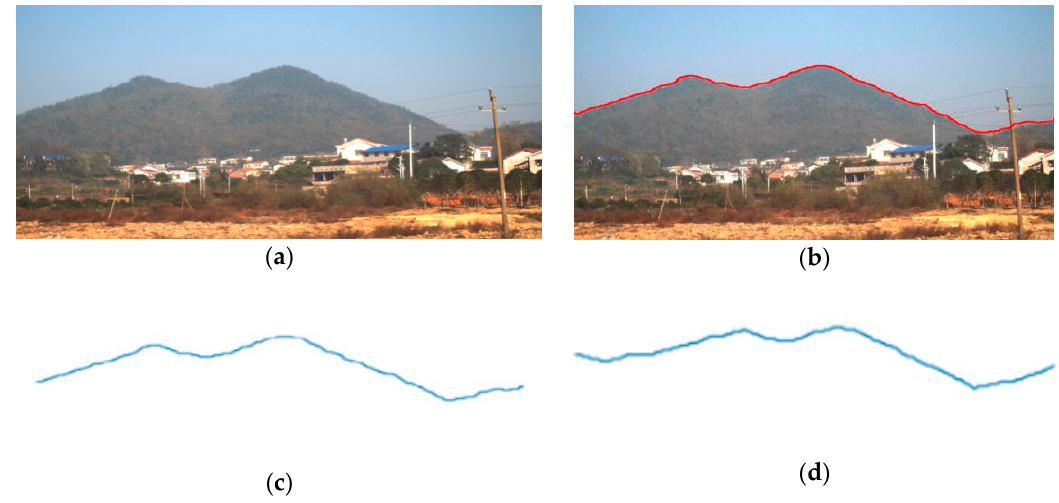
Figure 27. Some differences between the photo and DEM skylines: ( a ) Photo skyline; ( b ) Extracted skyline (denoted in red) superimposed on the photo skyline; ( c ) Extracted skyline; and ( d ) The ground truth of DEM skyline.